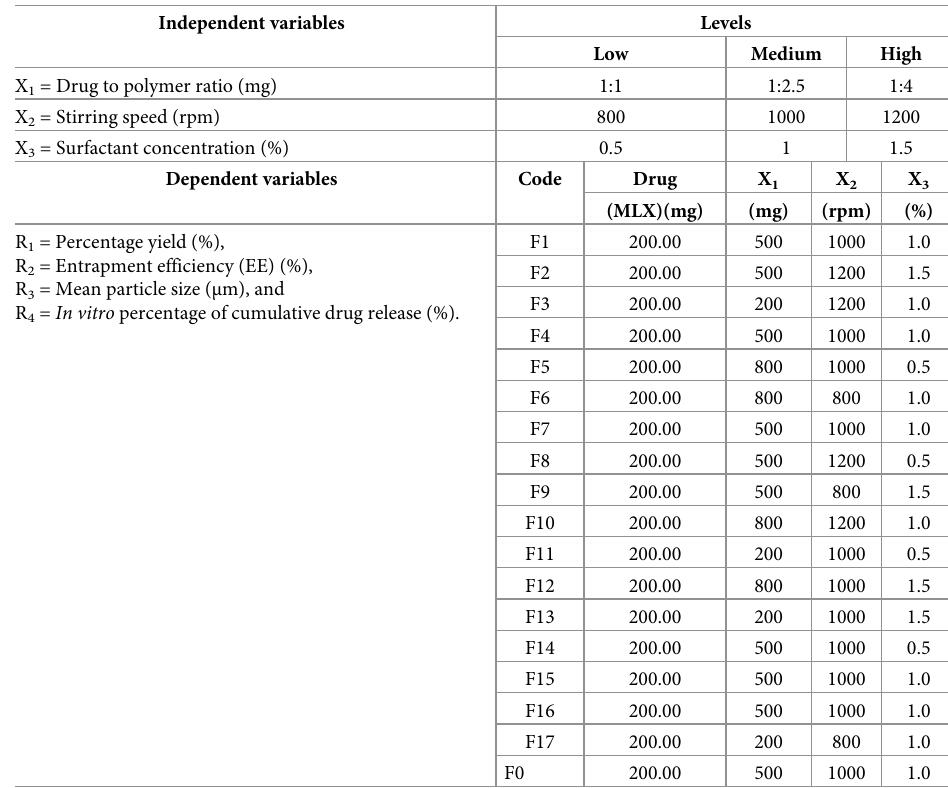
Table 1. Box Behnken Design (BBD) based experimental